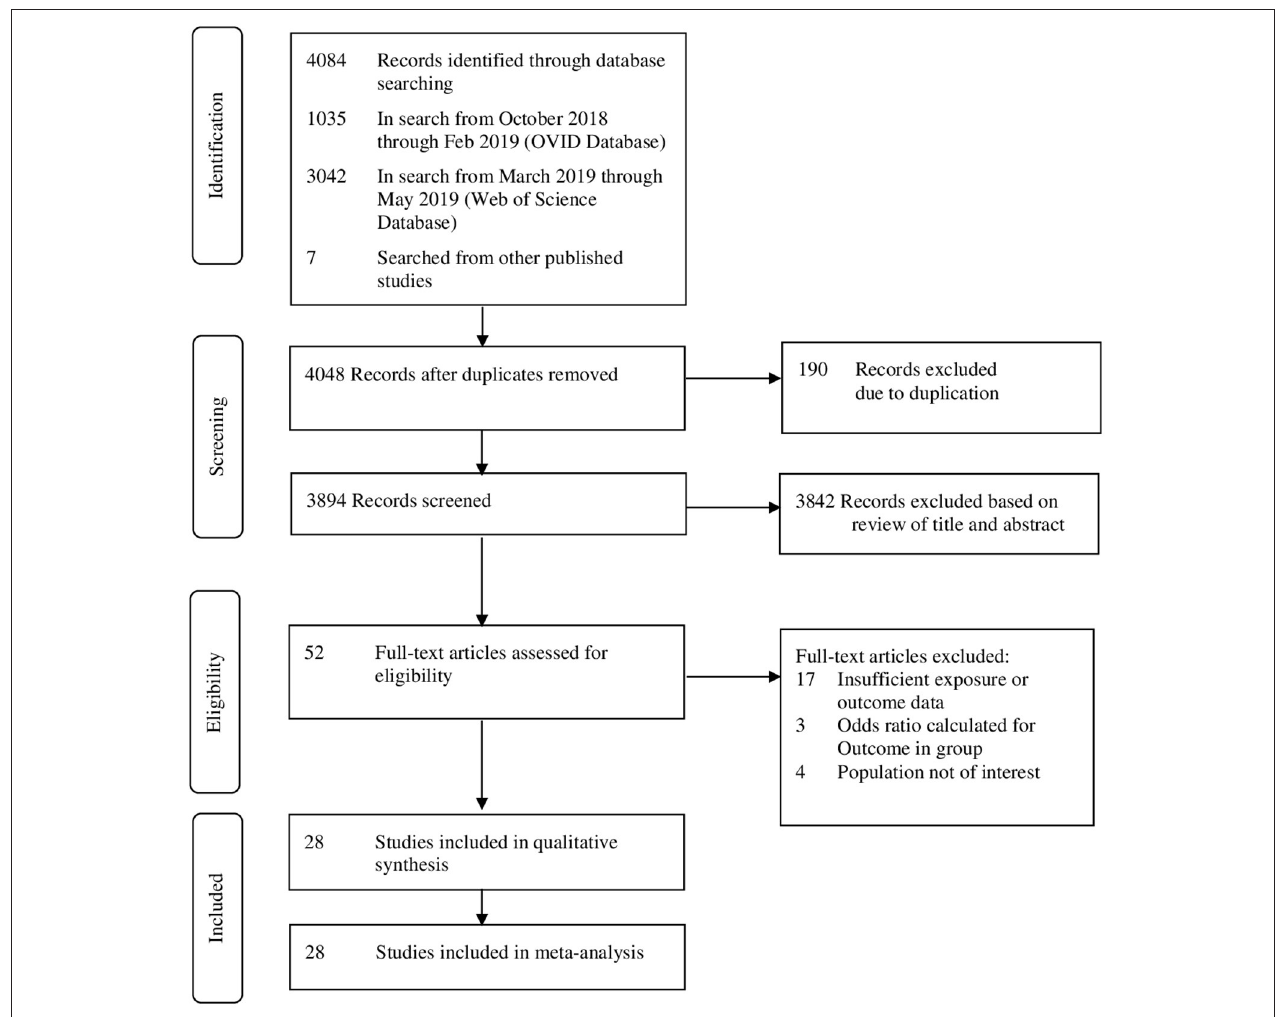
classification: 0–4 stars defined as low-quality, 5–6 stars defined as medium quality, and 7–9 stars as